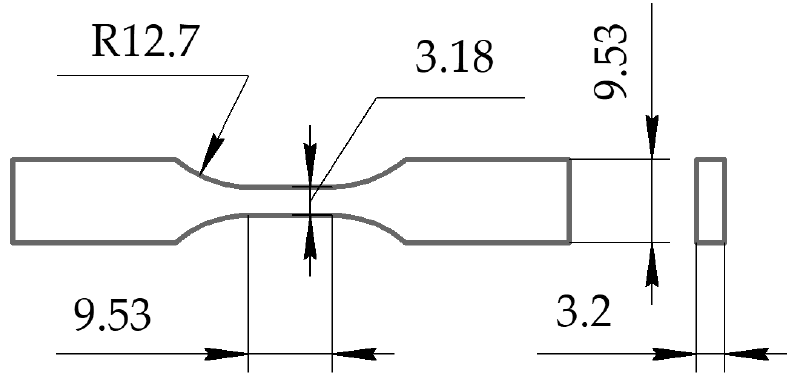
Figure 2. A scheme of the specimens for the static tension and fatigue tests (all dimensions in mm). The strain values were sampled at a frequency of 5 Hz and then evaluated by the DIC method. For drawing the strain fields, a speckle pattern was deposited on the sam- ple surfaces, which was captured with “Point Gray Grasshopper 50S5M” digital